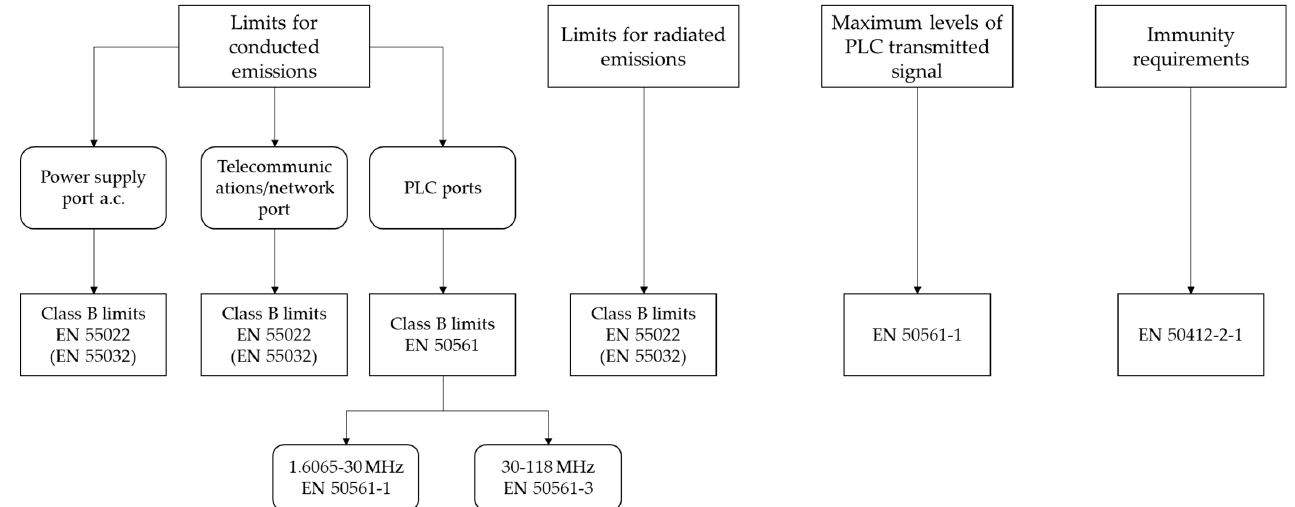
Figure 2. Limits for conducted and radiated emissions, PLC transmitted signal maximum levels, and immunity